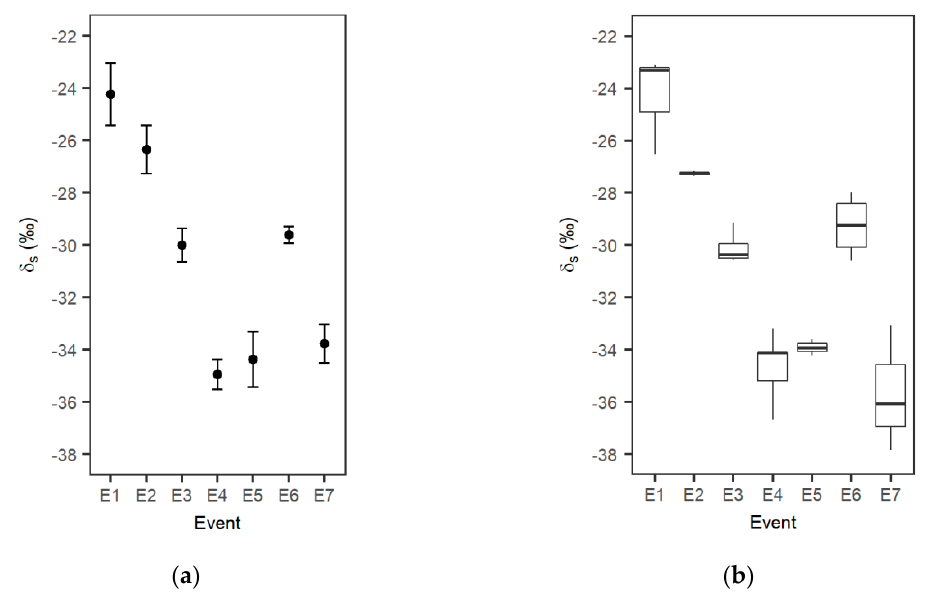
Figure 3. Intercepts of Keeling plots ( δ s ) during the individual pollution events. ( a ) Results of the classical Keeling plot method. Black circles indicate the intercept and the error bars show the error of the intercept. ( b ) Results of moving the Keeling plot method depicted as box plots. The whiskers of the boxplots indicate the minimum and maximum values, the lower and upper boundaries of the boxes are the 25th- and 75th-percentiles, and the horizontal lines inside boxes represent medians.